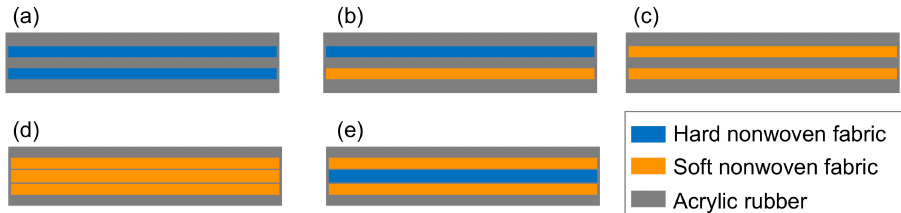
Figure 3. Schematic of the fabrication procedure of dura-mater models.